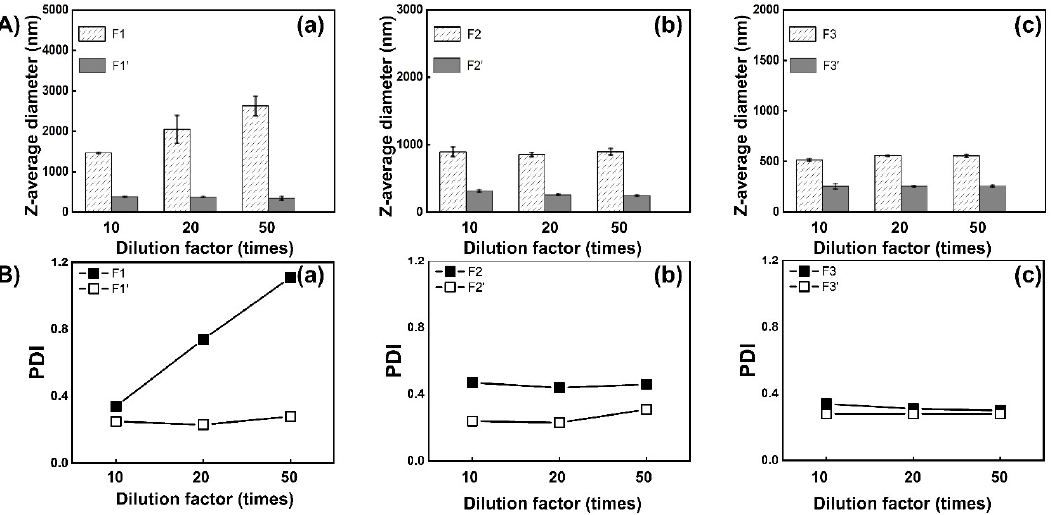
Figure 4. ( A ) Z-average, and ( B ) polydispersity index (PDI, plotted as black squares), of emulsions with respect to dilution factor for ( a ) F1 and F1′, ( b ) F2 and F2′, and ( c ) F3 and F3′.